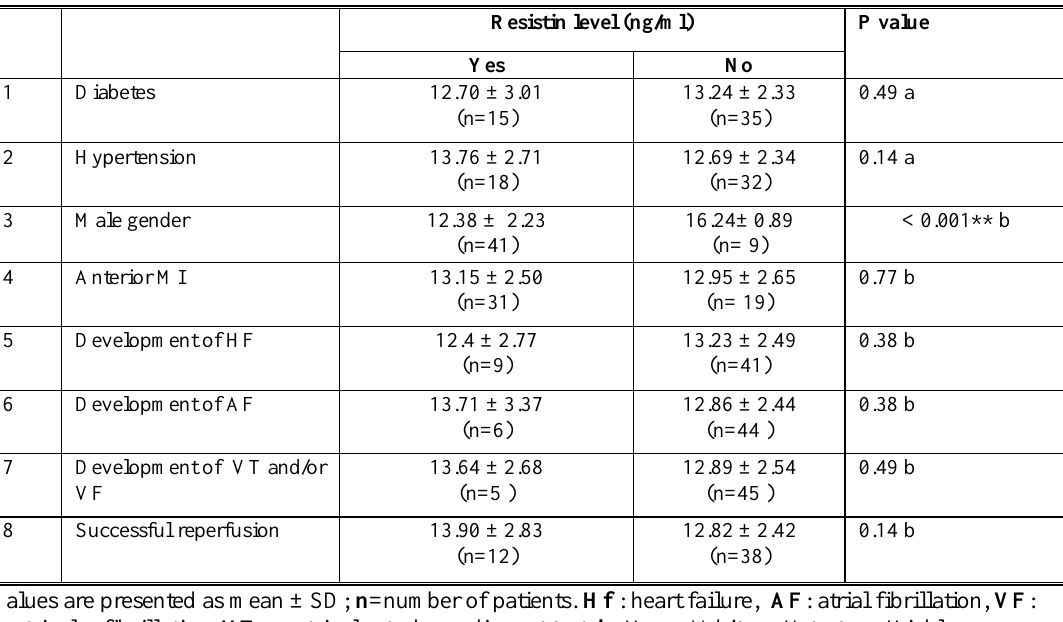
Table 3: Association of admission resistin level to selected clinical variables among patients with STEM.